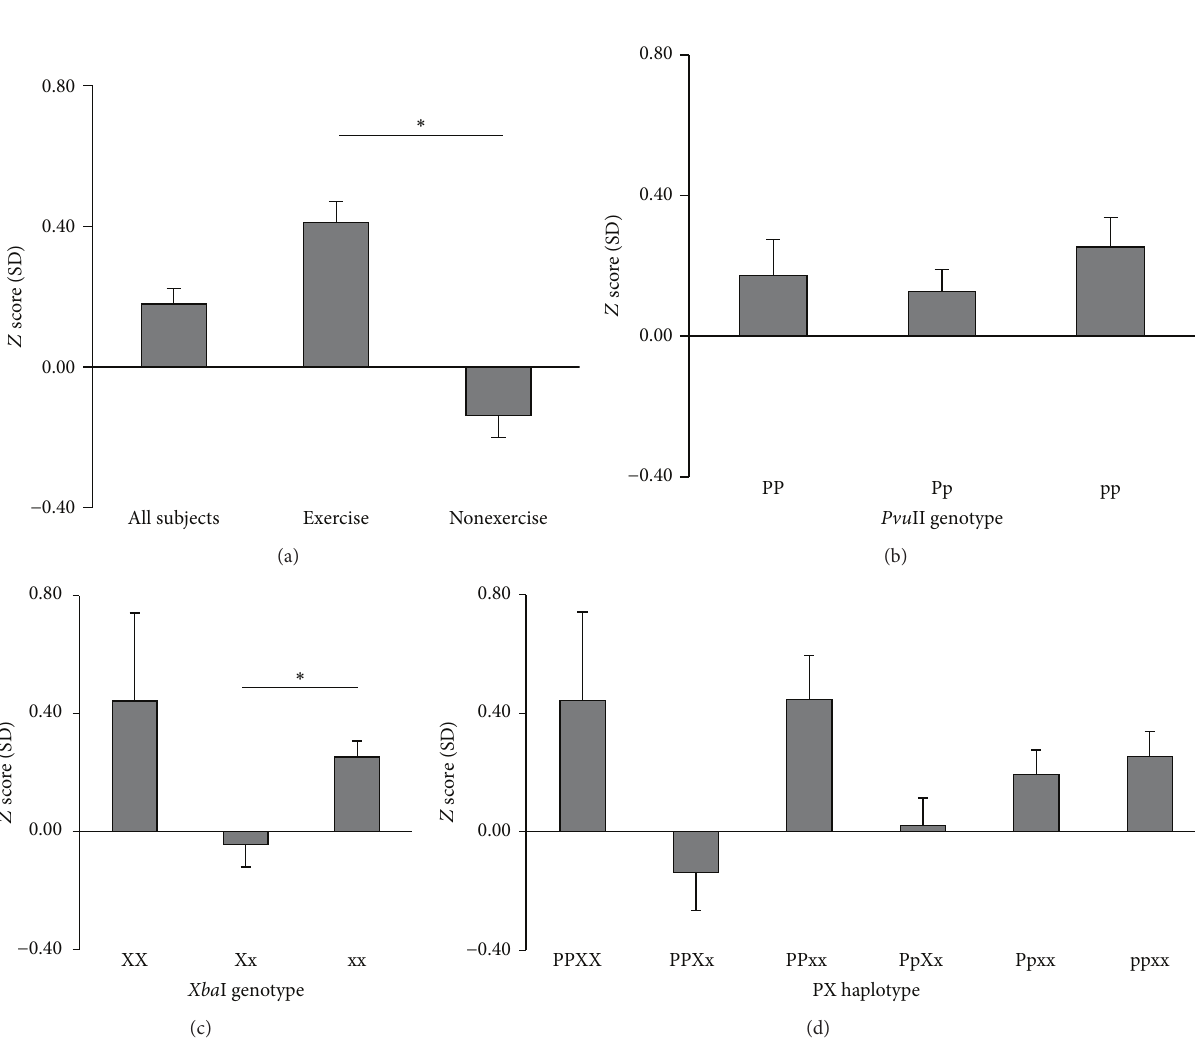
Figure 1: Dependence of bone density 𝑍 scores on Pvu II and Xba I RFLP genotypes and haplotypes. Values are expressed as mean ± SEM. The zero line is equal to the age-based mean value. ∗ 𝑃 < 0.05 compared between the exercise and nonexercise groups in each ER 𝛼 genotype and haplotype. (a) The 𝑍 score (SD) of the exercise group was significantly higher than that of the nonexercise group. (b) pp showed higher 𝑍 score than Pp, but there was no significant difference. (c) In the Xba I genotype, the 𝑍 score of xx was significantly higher than that of Xx genotype. (d) The 𝑍 score of PPXX and Ppxx was significantly higher than other genotypes, but there was no significant